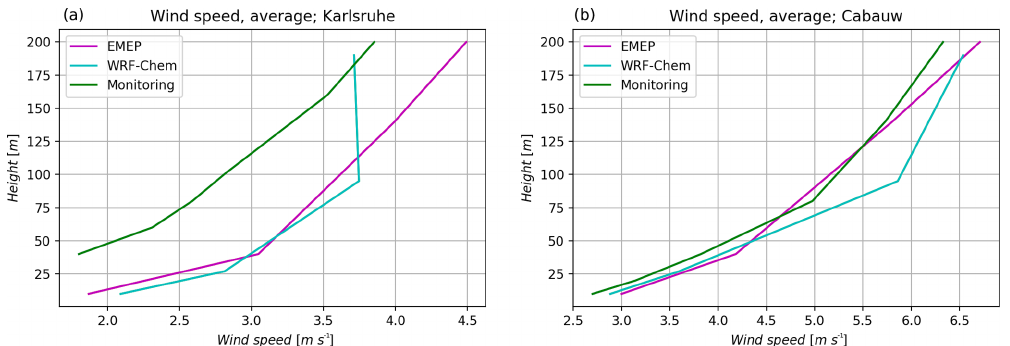
Figure 6. Vertical profiles of measured and modelled wind speeds at Karlsruhe ( a , measurement source: Institute of Meteorology and Climate Research, Atmospheric Environmental Research, Karlsruhe Institute of Technology) and the Cabauw mast station ( b , measurement source: Cesar Observatory, http://www.cesar-observatory.nl, last access: 12 May 2020) during November